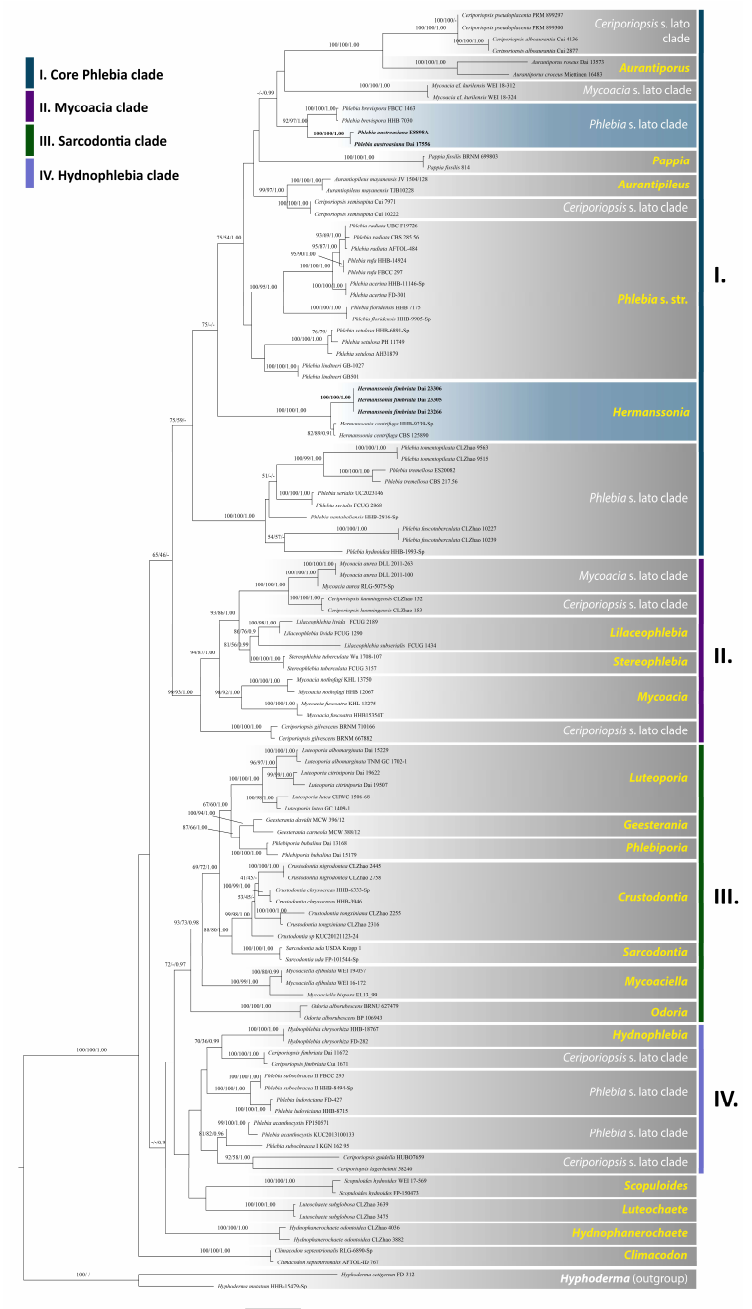
Figure 1. Phylogeny of Meruliaceae by MP analysis based on combined ITS and nLSU rDNA sequences. Branches are labelled with maximum likelihood bootstrap > 75%, parsimony bootstrap proportions > 50%, and Bayesian posterior probabilities > 0.9, respectively. New species are in